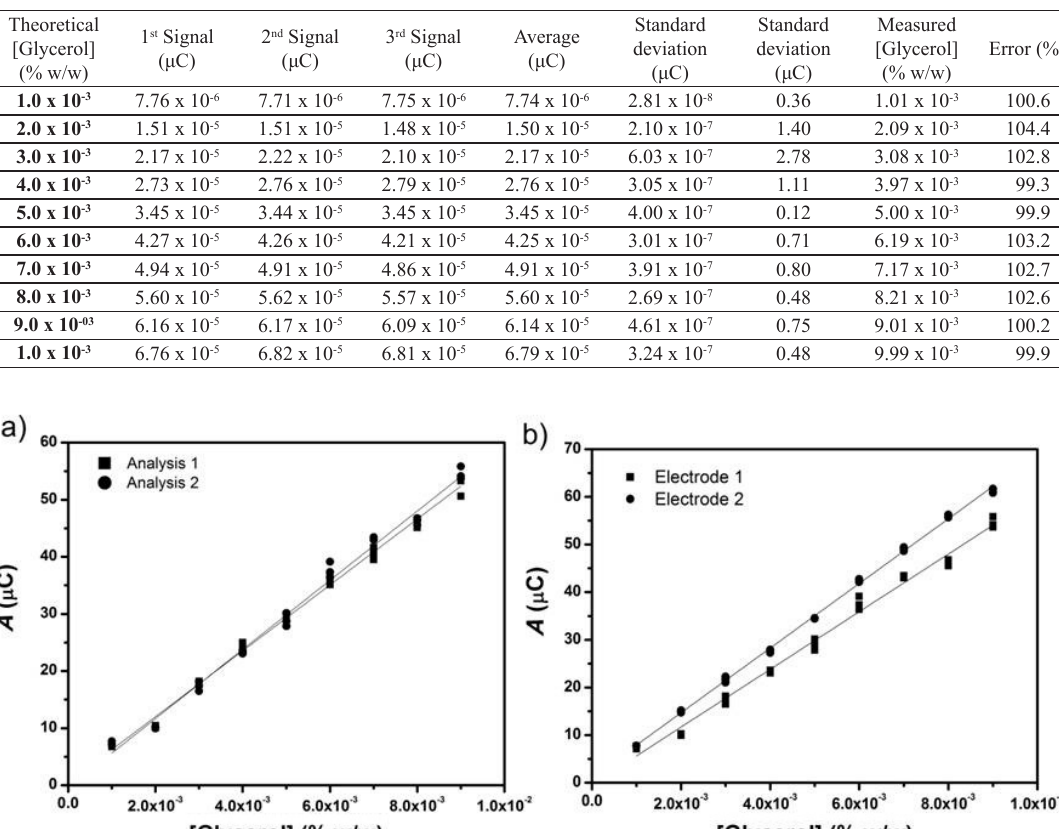
Table 1. Recovery results using the voltammetric method. Theoretical [Glycerol]